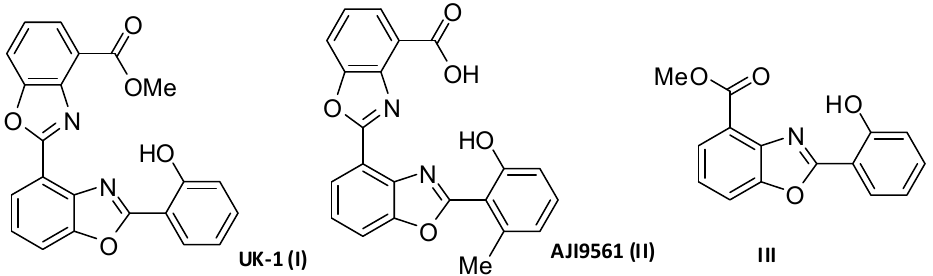
Figure 1. Structures of 2-(2-hydroxyphenyl)benzoxazole analogs as cytotoxic compounds against the human cancer cell lines [10].